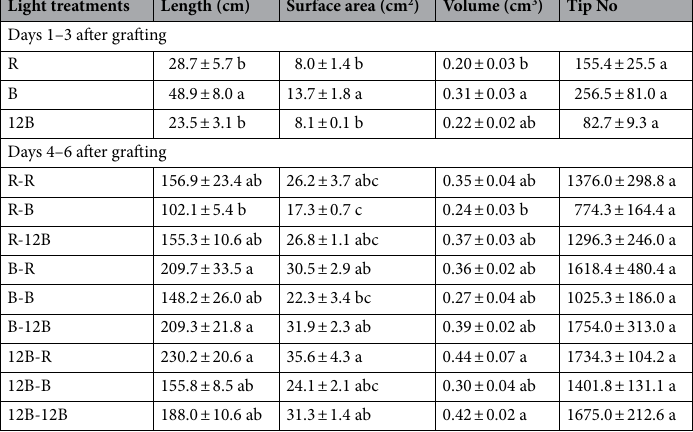
Light treatments Length (cm) Surface area (cm 2 ) Volume (cm 3 ) Tip